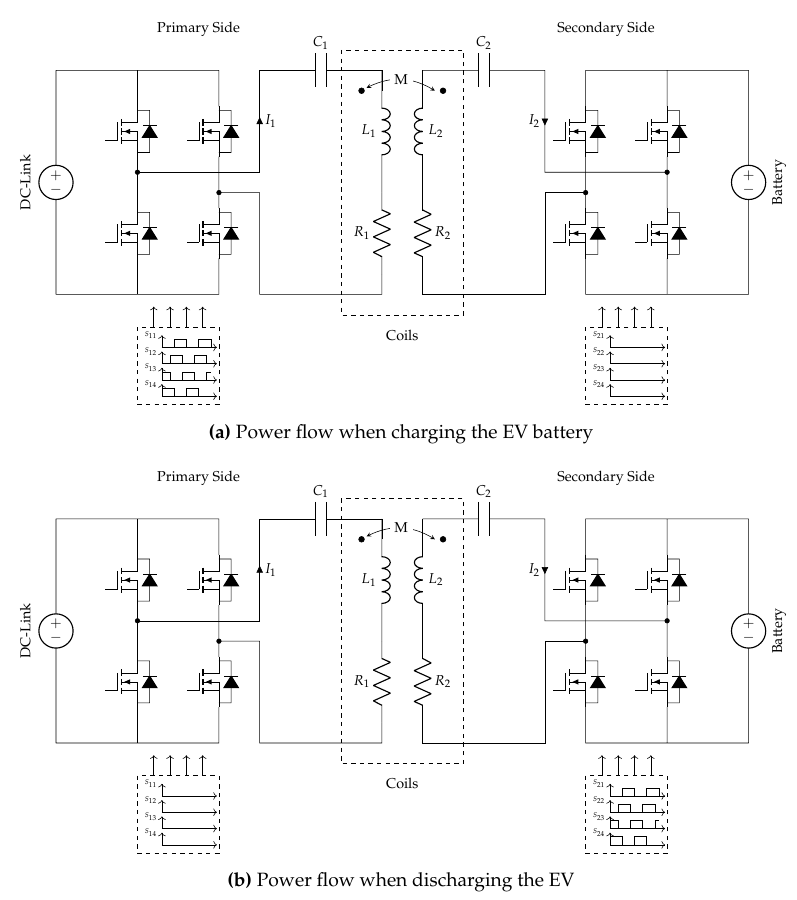
Figure 9. Power electronics and control signals of a Series-Series bidirectional charger with only one active power converter.